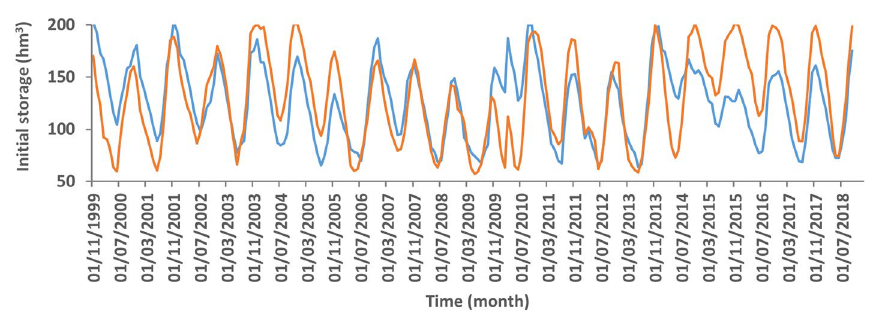
Fig. 9 The monthly initial water storage level of the Valle de Bravo reservoir: the historical record versus the simulated values calculated with genetic algorithm